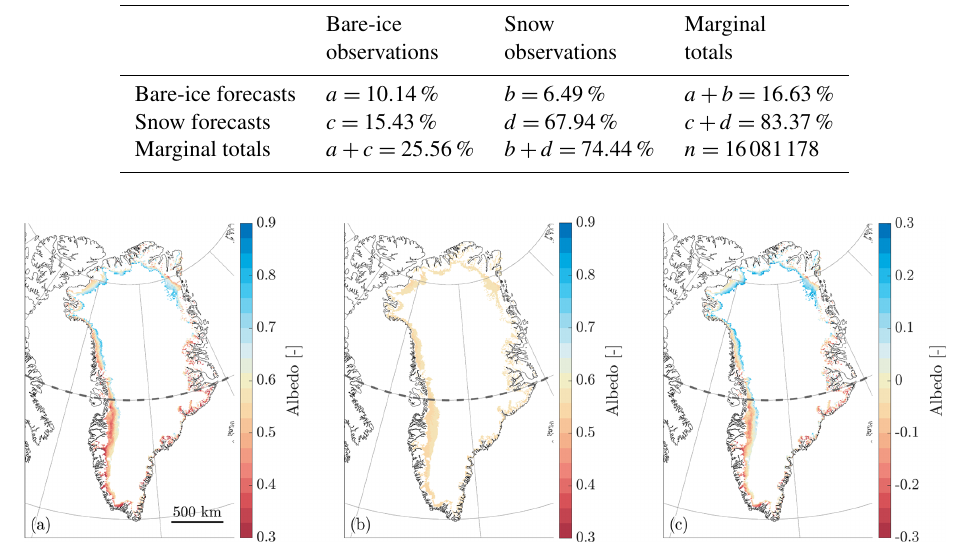
Figure 4. Maps of bare-ice albedo over maximum bare-ice extent averaged over JJA in 2000–2021 at 6.5km: (a) observed by MODIS, (b) modeled by MAR, and (c) their difference (MODIS minus MAR). The dashed line denotes 70 ◦